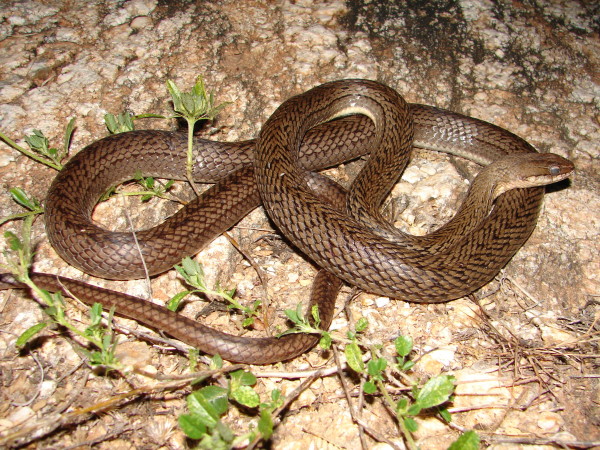
Philodryas nattereriSteindachner, 1870 (Figure33) (Photo - Washington Vieira).